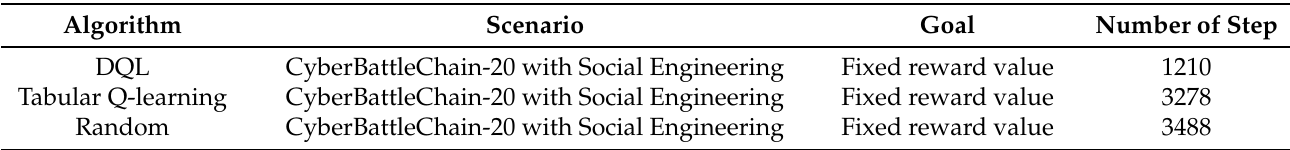
Table 8. Specific values of experimental results in Figure 13b.